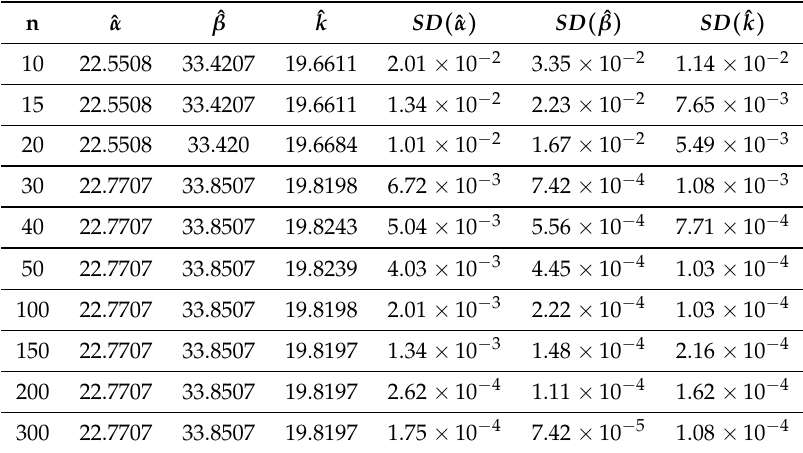
Table 3. Results of simulation with Newton’s method for m = 10,000 iterations, with α = 23, β = 34, k = 19, θ =